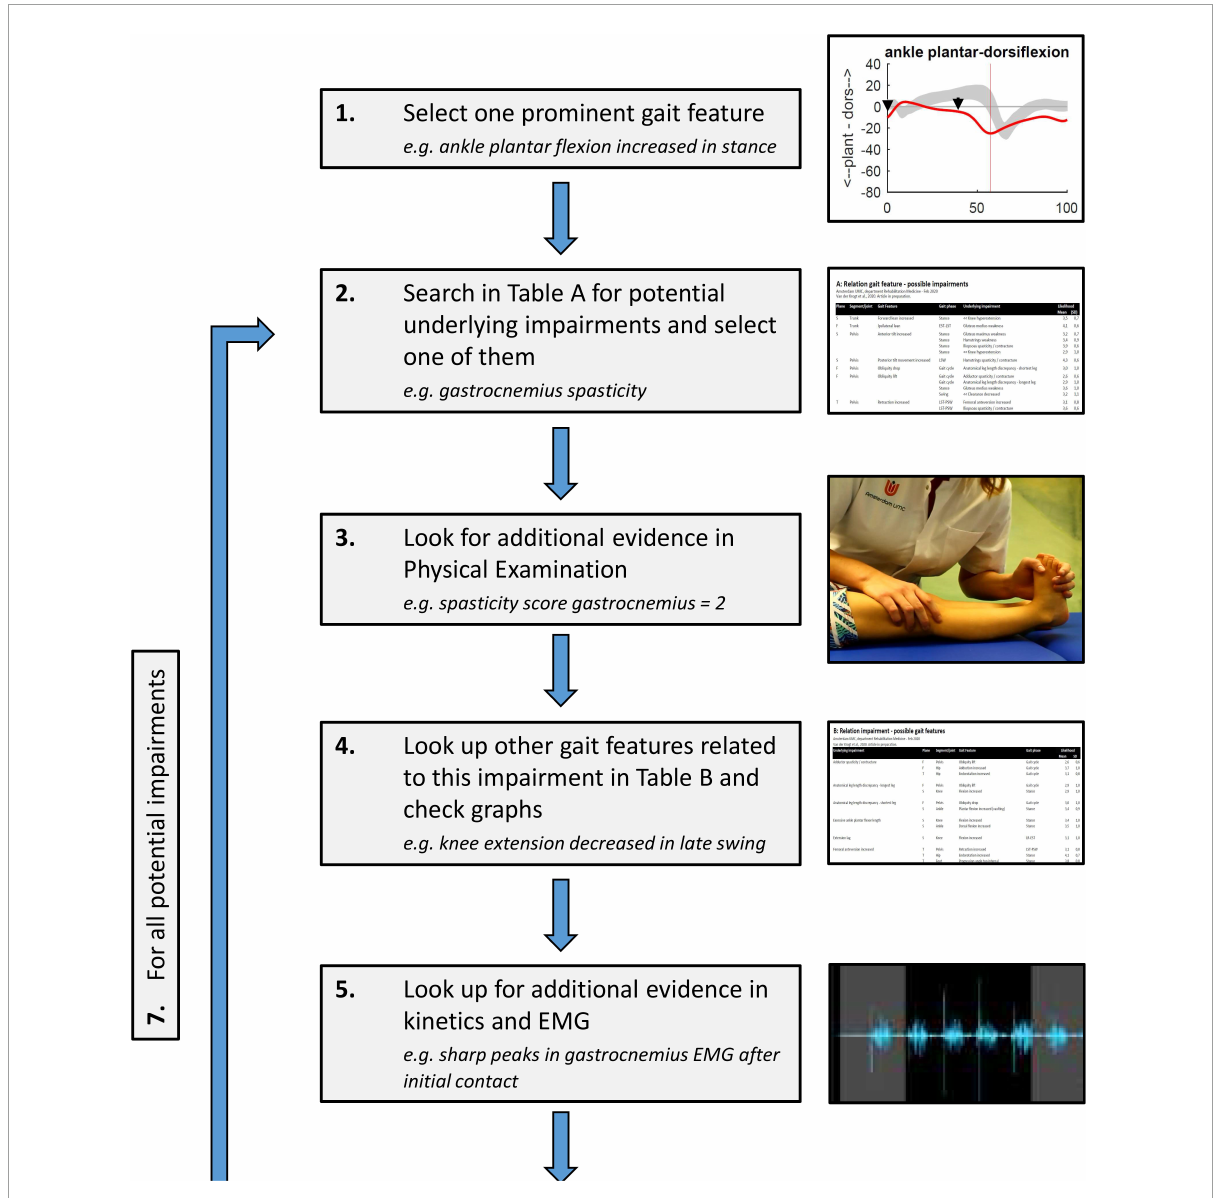
FIGURE3 Stepwise process of clinical reasoning using the developed look-up tables in Supplementary Appendixes A , B : (1) One kinematic gait feature is chosen, preferably related to the clinical problem of the patient; (2) A potential underlying impairment is identified using the table